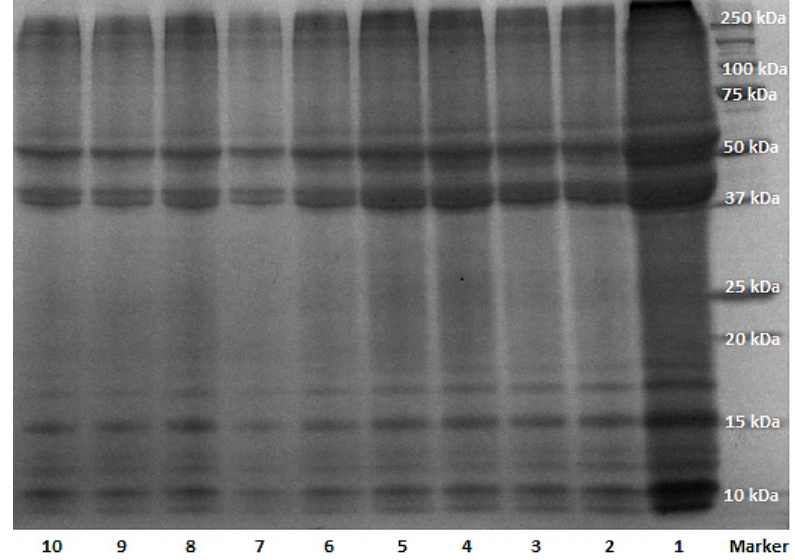
Figure 1. SDS-PAGE (sodium dodecyl sulphate polyacrylamide gel electrophoresis) of keratin extract from different steps of dialysis and diafiltration; samples 1–4: D0–D3 (D = dialyzed and the number corresponds to days); samples 5–10: DF1, DF3, DF5, DF8, DF10, DF14 (DF = dialyzed and diafiltered and the number corresponds to cycles).